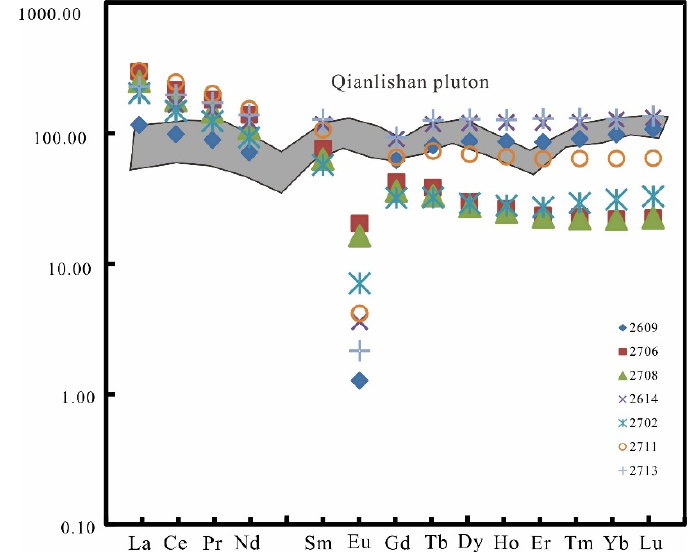
Figure 10. The four group effects of rare earth elements in the Xitian intrusion. The data of Qianlishan pluton are from [77].